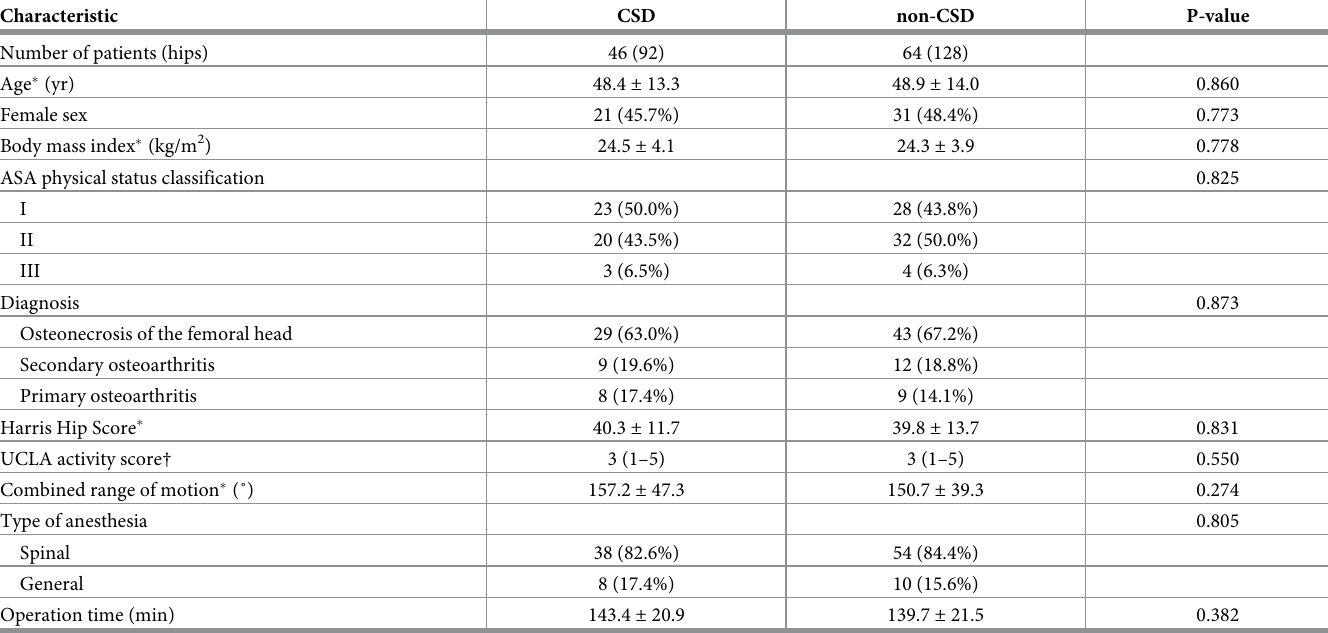
Table 1. Baseline information and surgical